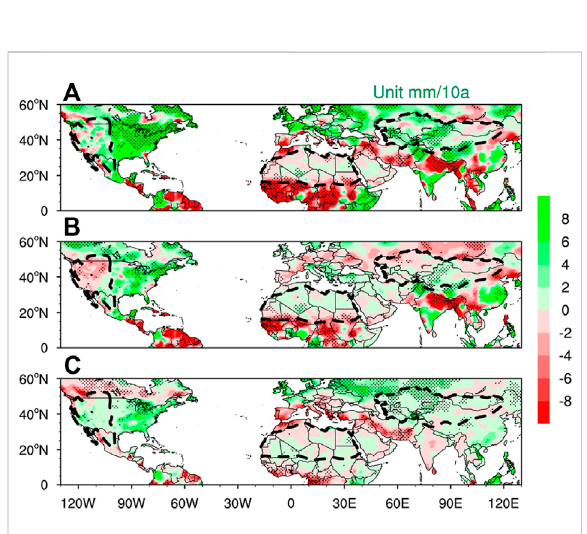
FIGURE 12 Variation rates of precipitation in (A) annual, (B) warm season and (C) cold season from 1941 to 2020. The dashed lines outline the study region, and the shaded areas indicate the values passing the signi fi cance test at the 95% con fi dence